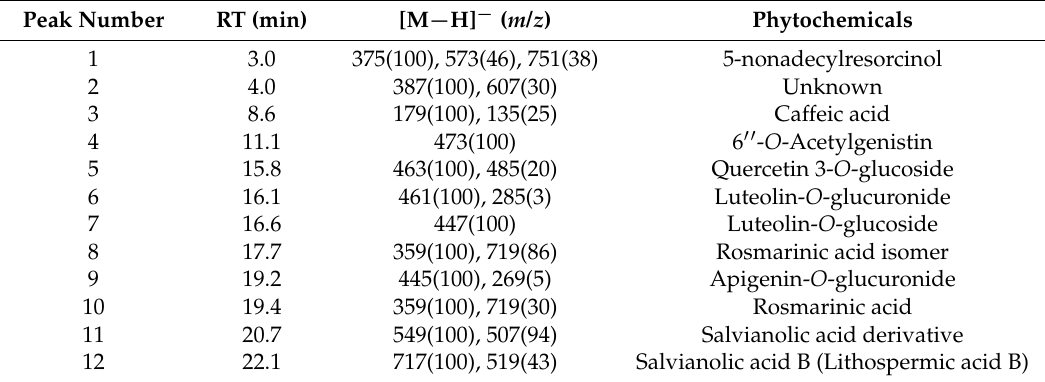
Table 1. Phytochemicals identified in methanolic and aqueous extracts of